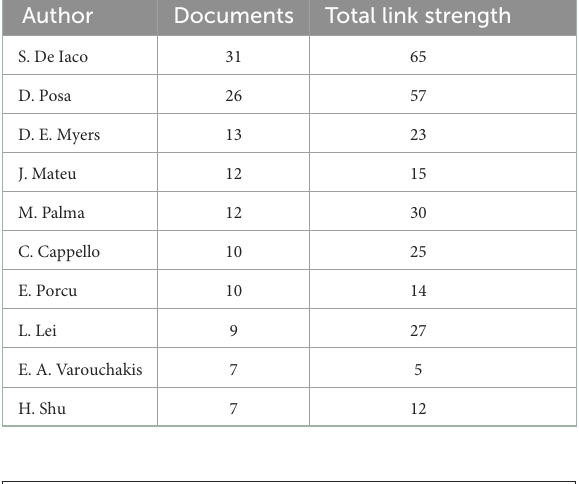
TABLE 5 Top 10 total link strength of co-citation analysis.